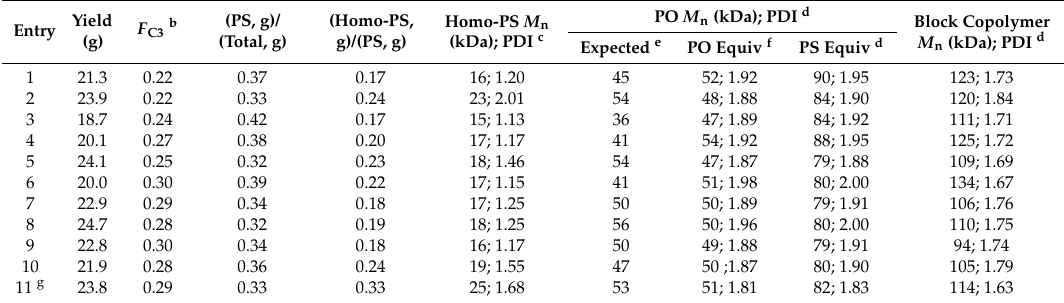
Table 1. Results of the sequential CCTP and anionic styrene polymerization process.